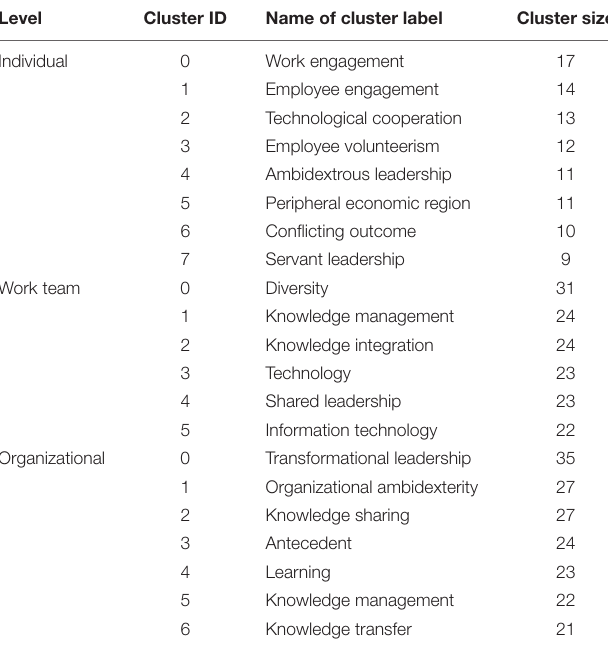
TABLE 5 | Clusters of research hotspots of innovation research at different